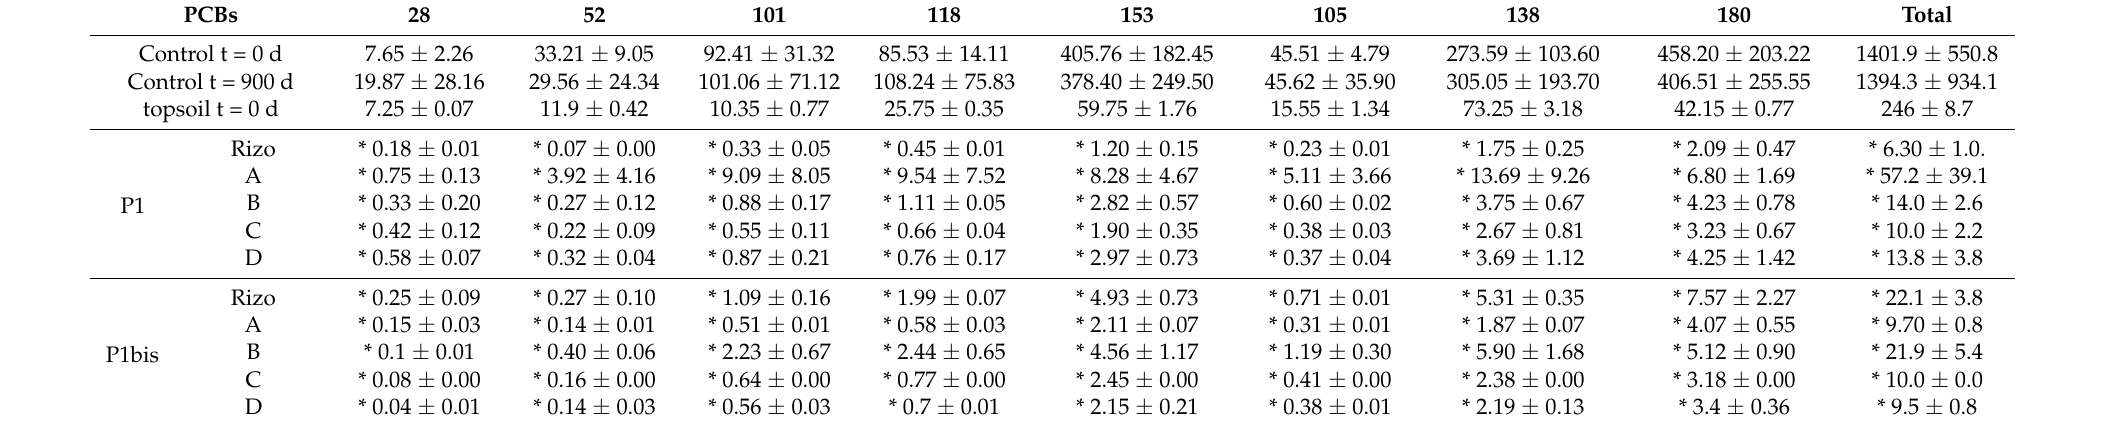
Table 3. Concentrations (average values (ng/g) ± standard deviation) of PCB congeners detected in: (i) soil samples at 0 day (topsoil: 0–20 cm depth) and 900 days after poplar planting. Rizo : soil surrounding the root system at 0–30 cm depth; A: 0.25 m distance from the trunk and 0–20 cm depth; B: 0.25 m distance from the trunk and 20–40 cm depth; C: 1 m distance from the trunk and 0–20 cm depth; D: 1 m distance from the trunk and 20–40 cm depth); and (ii) soil samples at 0 and 900 days taken from the control plot. Statistical differences ( p < 0.001) are reported with a star